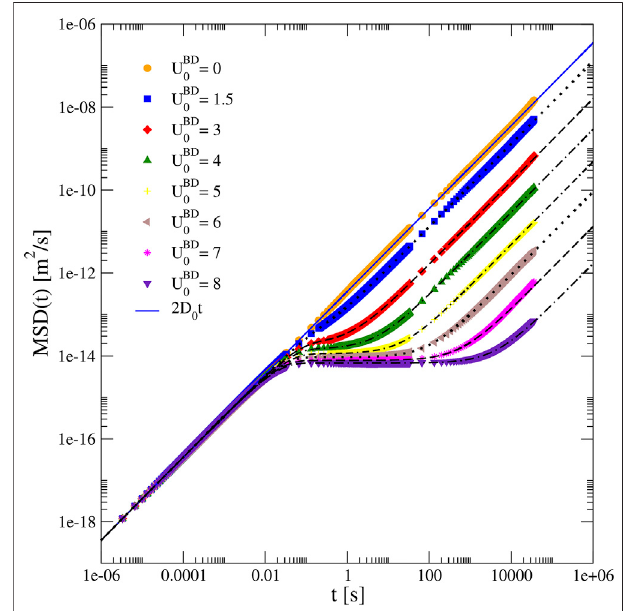
spherical tracer as a function of time in the presence of a periodic cosine-like potential of amplitude U 0 . Solid symbols correspond to Brownian dynamics simulations in which L (cid:2) 1 . 0 × 10 − 6 m and D BD 0 (cid:2) D 0 (cid:2) 1 . 8 × 10 − 13 m 2 / s for several U BD 0 values (in k B T units). Dotted, dashed, and dot-dashed black lines correspond to Bellour fi ttings ( Eq. 5 ) using the parameters displayed